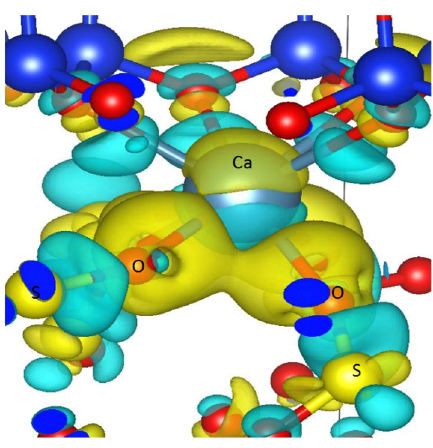
Figure 8. Differential charge density around Ca atoms after adsorption. Yellow color indicates electron accumulation and cyan color indicates electron